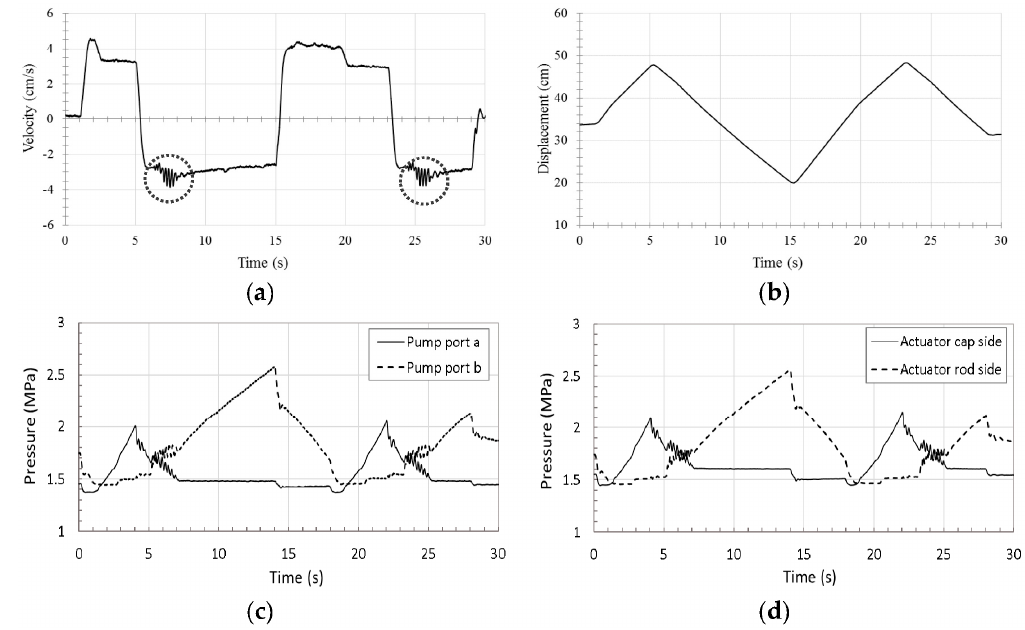
Figure 11. Performance of the circuit utilizing only POCVs for control signal in Figure 10 at four quadrants of operation and 41 kg mass: ( a ) actuator velocity, v a ; ( b ) actuator displacement; ( c ) pressures at pump ports a, p a and b, p b ; and ( d ) pressures at actuator ports a, p A and b, p B . Oscillations are experienced at time periods 6 s–7 s and 24 s–25 s and circled in the velocity graph.